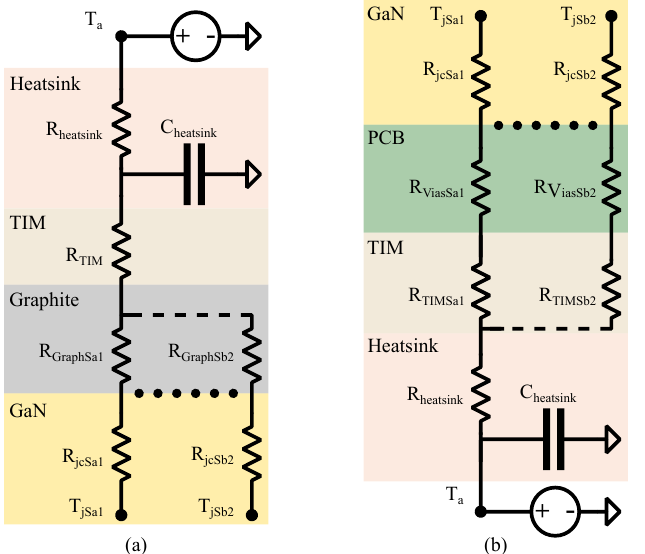
Figure 5. Thermal model of a converter with: ( a ) top-side cooled GaN-eHEMTs; and ( b ) bottom-side cooled GaN e-HEMTs.